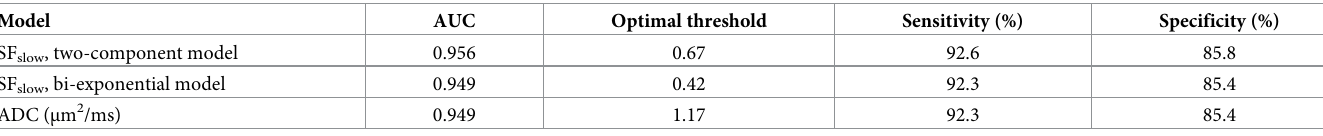
Table 2. Summary of Receiver Operating Characteristics (ROC) results.